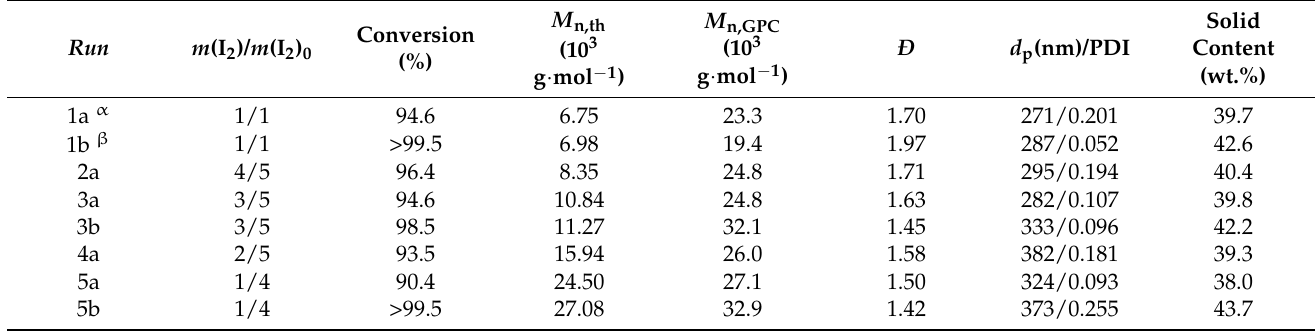
Table 10. Influence of iodine on emulsion with St units in polymer